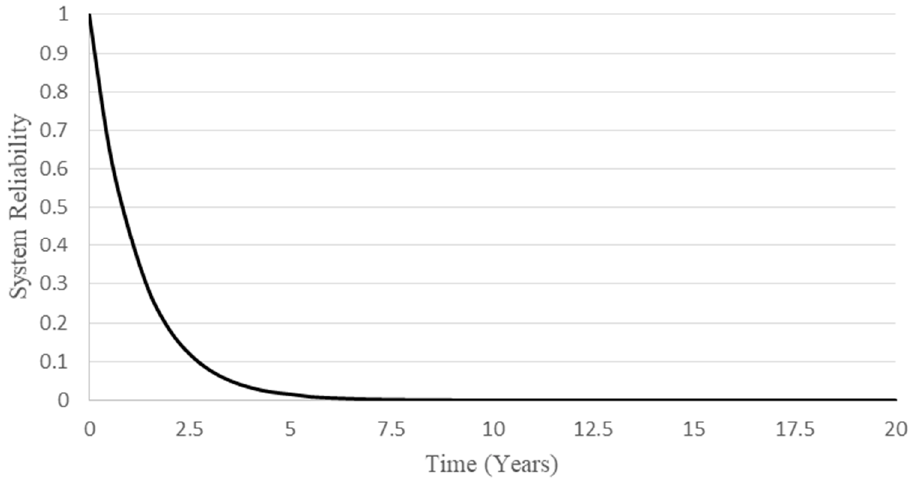
Figure 4. Unloading system reliability.